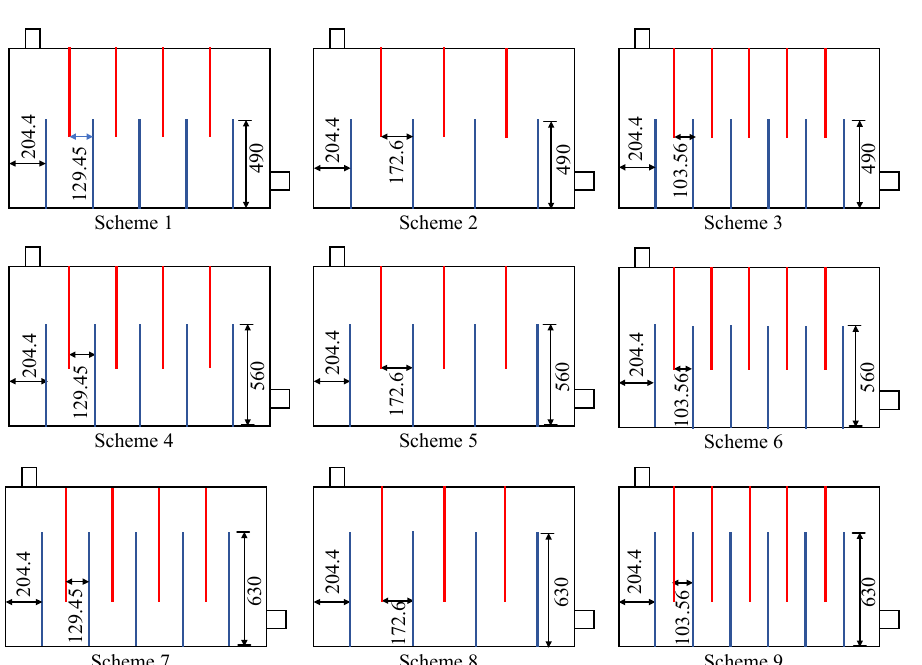
Figure 3. Test configuration options ( Scheme 1 is P s = 129.45 and P l = 490; Scheme 2 is P s = 172.6 and P l = 490; Scheme 3 is P s = 103.56 and P l = 490; Scheme 4 is P s = 129.45 and P l = 560; Scheme 5 is P s = 172.6 and P l = 560; Scheme 6 is P s = 103.56 and P l = 560; Scheme 7 is P s = 129.45 and P l = 630; Scheme 8 is P s = 172.6 and P l = 630; Scheme 9 is P s = 103.56 and P l = 630. All the above units are in mm).